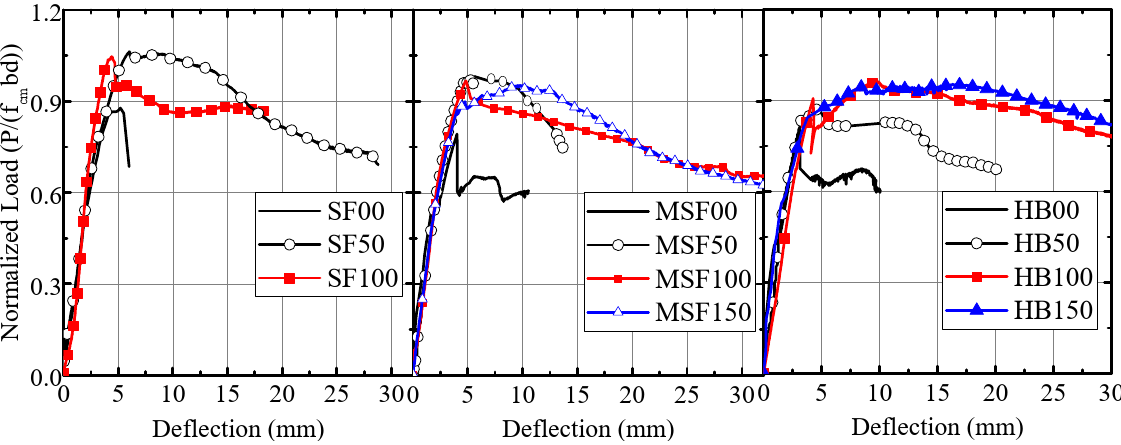
Figure 8. Normalized load–deflection curves of prestressed concrete beams reinforced with steel fibers (SF), macro-synthetic fibers (MSF), and hybrid fibers (HB).